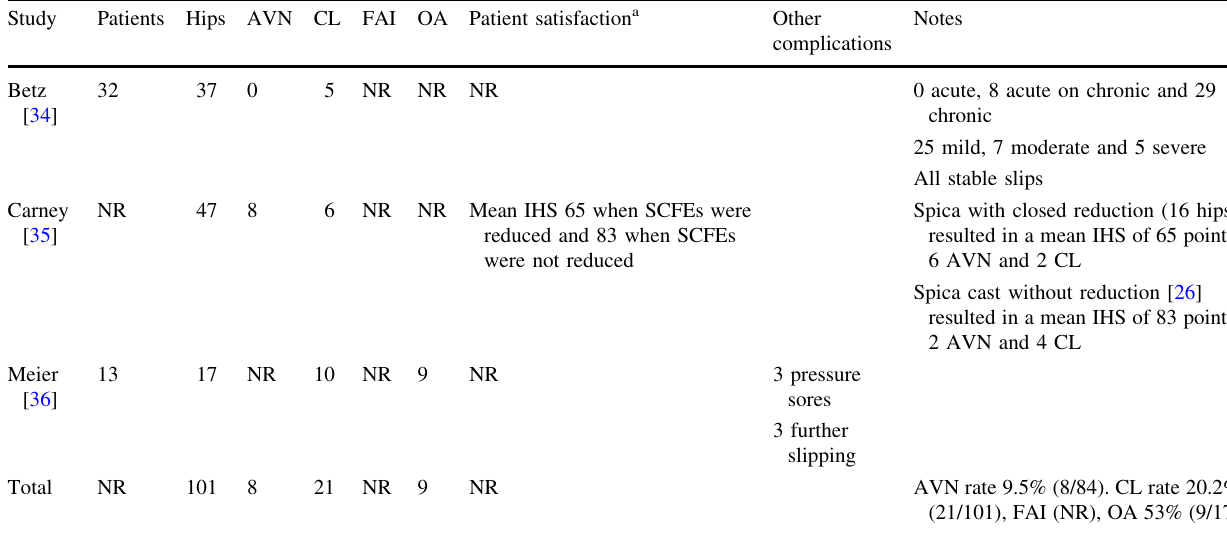
Table 4 Studies of hip spica treatment in stable slips